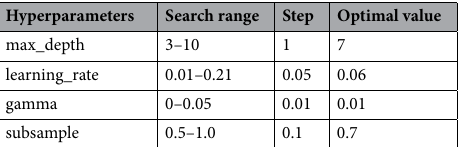
Table 2. Hyperparameters optimization process using the grid search